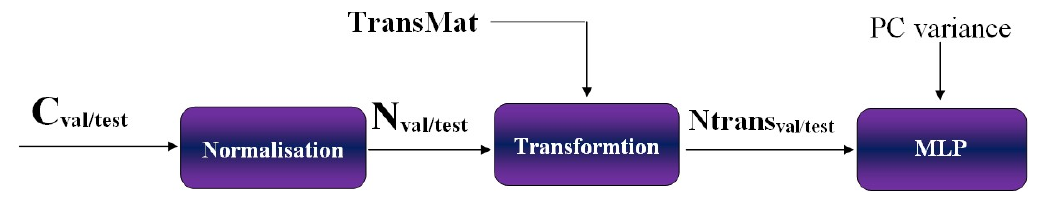
Figure 11. Schematic diagram of post-processing procedure.